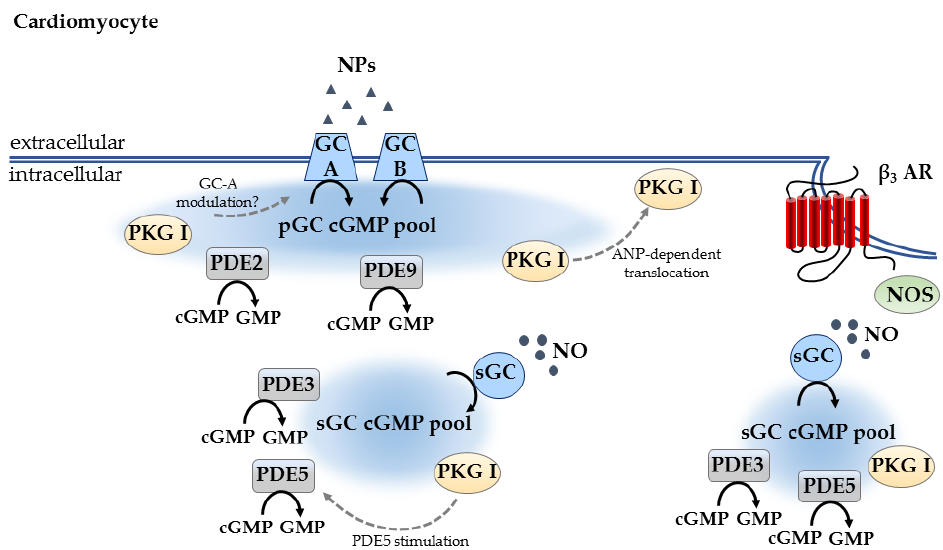
Figure 1. cGMP compartmentation in CMs. There are at least two different cGMP pools: the NP/pGC/cGMP pool formed at the plasma membrane, and the NO/sGC/cGMP pool which can be controlled by the β 3 -adrenergic receptor ( β 3 -AR) at the cell surface caveolae. pGC/cGMP is tightly controlled by PDE2 and PDE9, while sGC/cGMP pool is predominantly regulated by PDE5 and PDE3. PKG I is one of the major downstream targets for cGMP signaling. NO/sGC stimulated PKG I is known to phosphorylate and inhibit PDE5. ANP/pGC stimulated PKG I can be recruited to the plasma membrane and is assumed to modulate GC-A activity. Black arrows indicate enzymatic activity, dotted arrows indicate protein action.